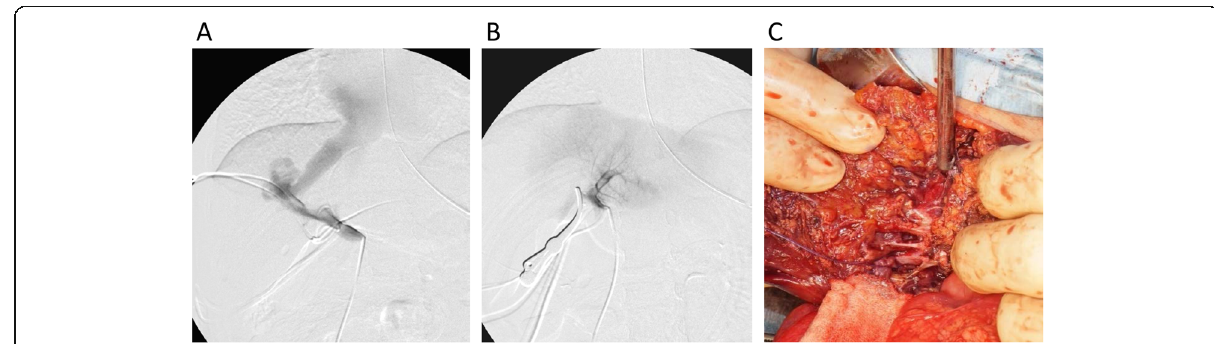
Fig. 3 Intraoperative findings. a Portography and measurement of portal vein pressure were performed. Before temporary occlusion of the right portal vein, portal vein pressure was 13 mmHg and portography showed almost all portal vein flow draining into the hepatic vein through the IPSS. b After the temporary occlusion of the right portal vein, the portal vein pressure was 16 mmHg, and portography showed good contrast of left portal vein, intrahepatic portal vein, and hepatic vein and no IPSS in the left lobe. c A collection of multiple vessels was observed that